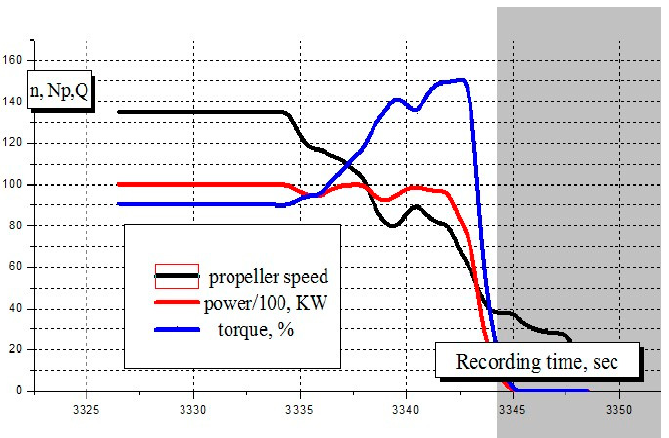
Figure 9. Electric engine torque change due to operation in ice at off-design regime with a rapid power and propeller speed drop. Large capacity tanker in astern mode in ridges [7].